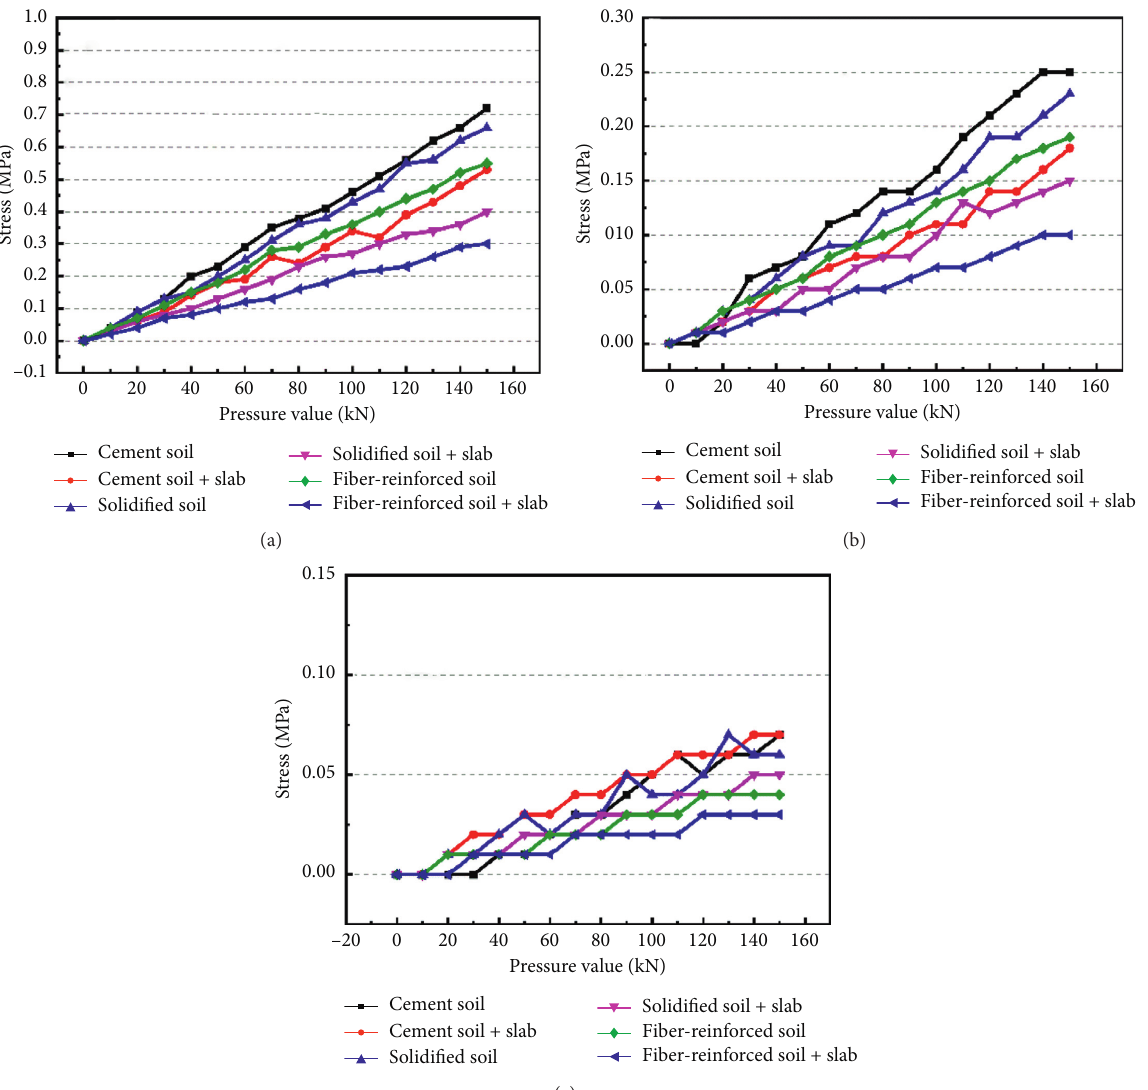
Figure 16: Stress variation rules for each structural layer under static load. (a) Bottom of base course. (b) Bottom of subbase. (c) Bottom of compacted soil